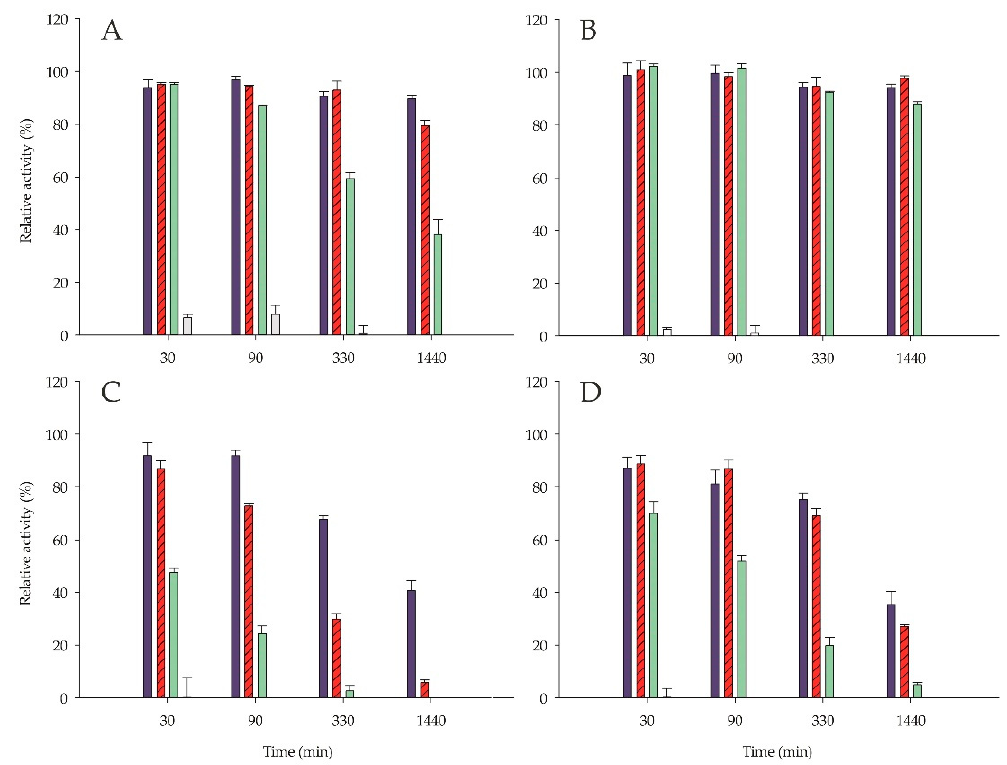
Figure 8. Stability of proROL and rROL in solution in the presence of ethanol and methanol at four di ff erent concentrations. ( A ) proROL in ethanol, ( B ) proROL in methanol, ( C ) rROL in ethanol, and ( D ) rROL in methanol. Activity values relative to t = 0. Alcohol concentration: 0% (black), 5% (striped-white), 15% (gray), and 30%